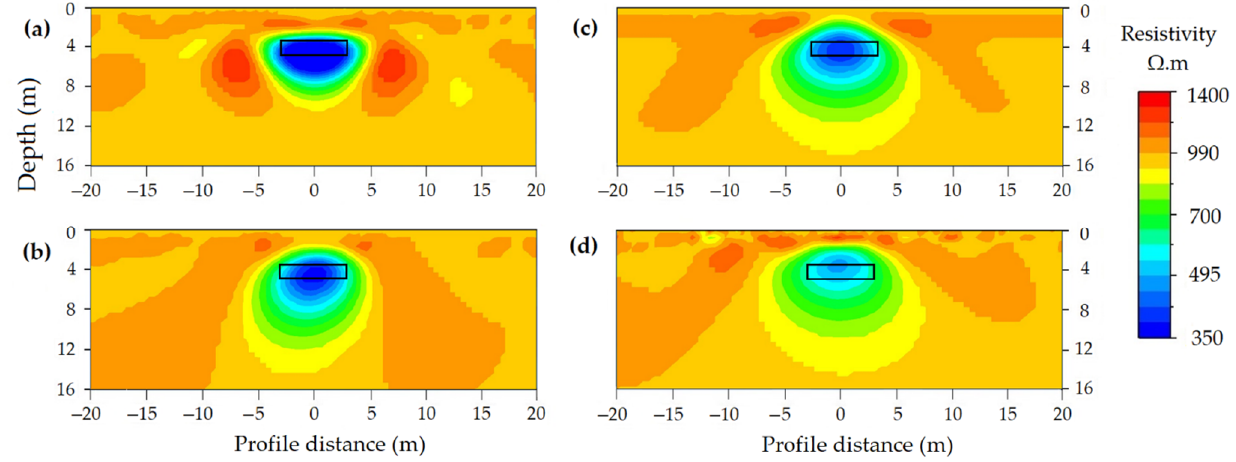
18 of 32 Figure 18. The inverted resistivity models for the cavity geometries using: ( a ) DD array, ( b ) PD array, ( c ) WS array, ( d ) PP array. The solid line indicates the actual cavity targets. Conductive Cavity Modeling The air-filled cavity showed a high anomaly in resistivity imaging, while a conduc- tive cavity appeared as a low anomaly. For conductive cavity modeling, a cavity with a 1.5 × 6 m dimension set at 4.2 m depth was filled with dry clay (90 Ω·m) and saturated clay (50 Ω·m). Figure 19 shows the inverted model results for a cavity filled with dry clay. The DD array accurately resolved the cavity; however, the anomaly size was higher than the actual